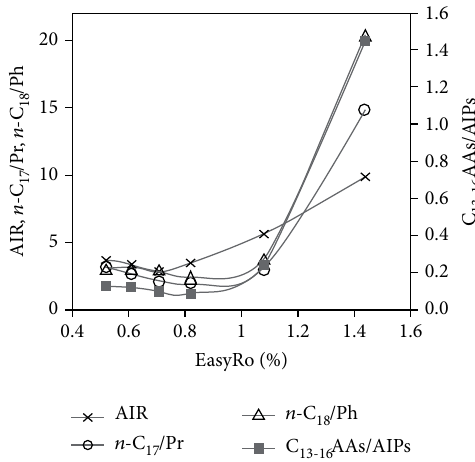
Figure 6: Variations in the selected molecular ratios with EasyRo values. The C AA/AIP ratio represents the sum of C AA 13-16 13-16 AIPs; C AAs were not peak area divided by that of C 13-16 17-22 included due to their identi fi cation with less con fi dence in the relatively low-temperature pyrolysates. The n -C /Pr and n - 17 C /Ph ratios were extracted from our previous study 18